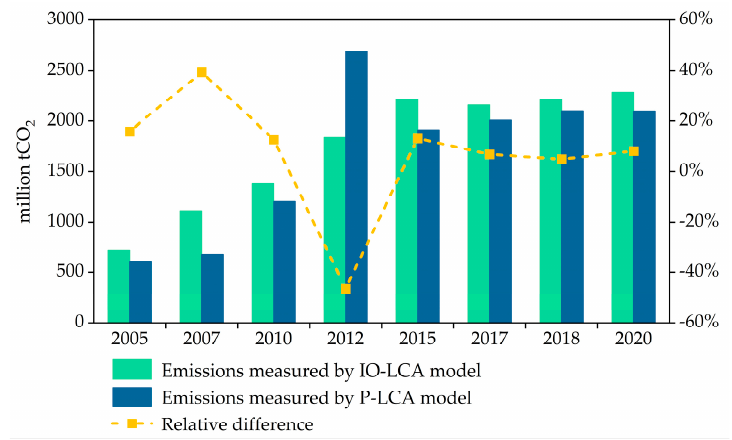
Figure 17. Comparison of the accounting results.